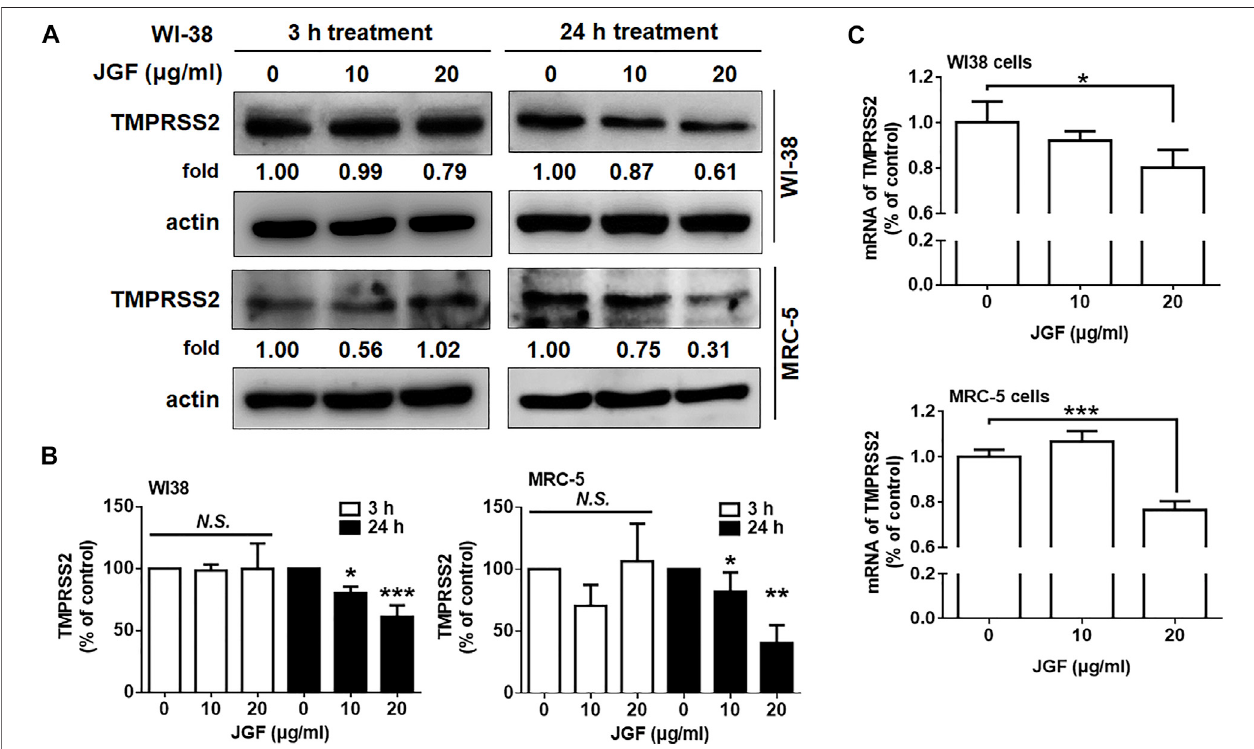
FIGURE 4 | JGF reduces TMPRSS2 levels in WI-38 cells. (A) WI-38 cells were treated with JGF (0 – 20 μ g/ml) for 3 and 24 h. Western blotting was subsequently performed with whole cell lysates to detect the expression of TMPRSS2. Actin was used as the internal control. (B) Quanti fi cation of the intensities of the bands of TMPRSS2 was representative of three separated determinations by ImageJ. (C) WI-38 cells were treated with JGF (0, 10 and 20 μ g/ml) for 24 h. The mRNA levels of TMPRSS2 were determined by qRT-PCR. The data was presented as the mean ± SD; error bars indicated SD. Signi fi cant differences were shown (* p < 0.05 compared to the control